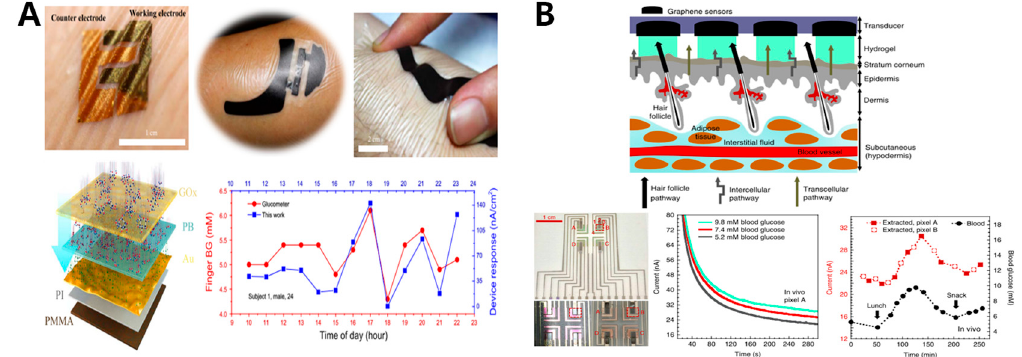
Figure 12. ISF-based glucose monitoring. ( A ) Skin-like biosensor system via electrochemical channels for noninvasive blood glucose monitoring. Adapted with permission [111]. Copyright 2017, Science advances. ( B ) Non-invasive, transdermal, path-selective and specific glucose monitoring via a graphene-based platform. Adapted with permission [142]. Copyright 2018, Nature Nanotechnology.